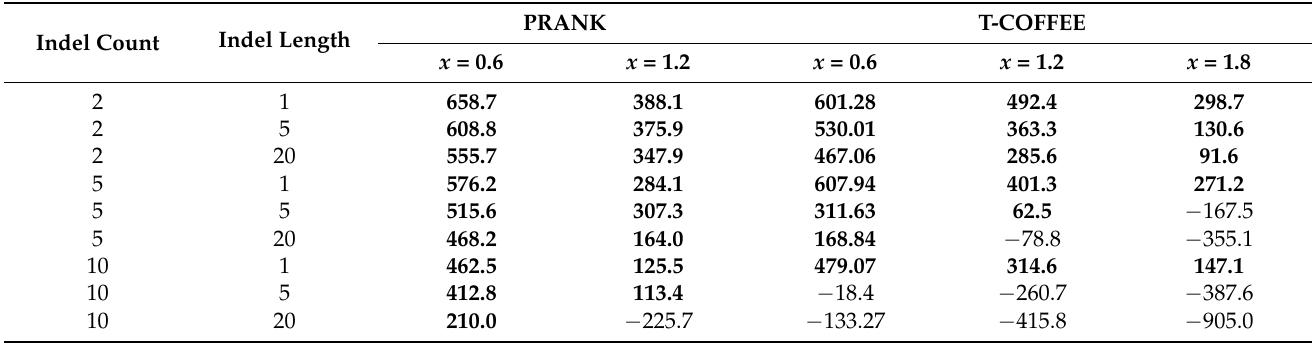
Table 6. Z values calculated for multiple alignments of 81 Des sets built using PRANK and T-Coffee ( Z > 10.0 are in